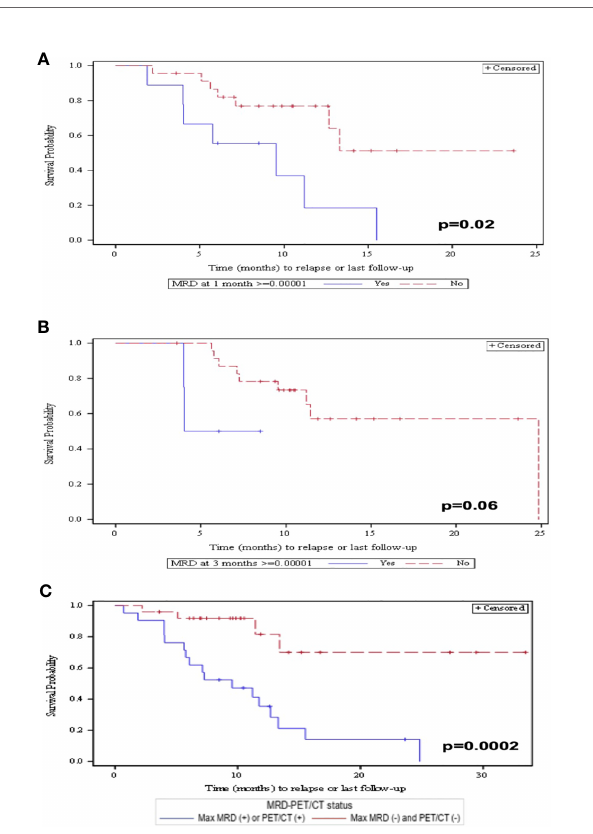
FIGURE 2 | (A) PFS at 1 month post-CAR-T by patients who obtained MRD <10 − 6 vs . MRD >10 − 6 . (B) PFS at 3 months post-CAR-T by patients who obtained MRD <10 − 6 vs . MRD >10 − 6 . (C) PFS by patients who achieved MRD <10 − 5 and PET/CT negativity compared with patients who have either MRD <10 − 5 or PET/CT